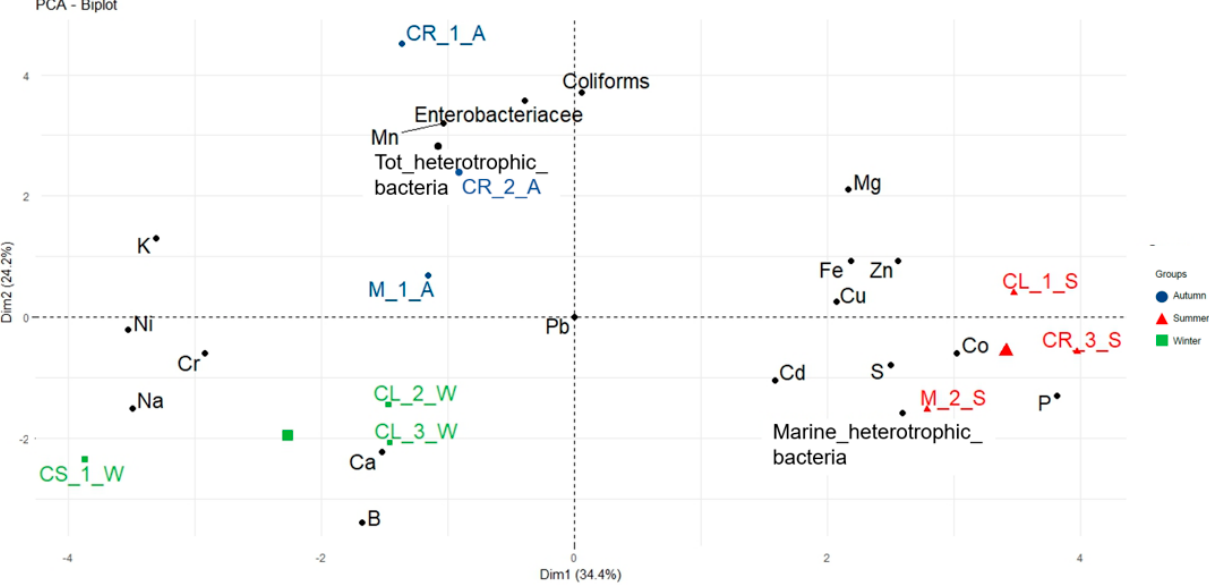
Figure 6. Principal component analysis of each fish species Chelon ramada (CR), Chelon labrosus (CL), Chelon saliens (CS), Mugil cephalus (MC) metal contents, and intestinal microbial loads along the seasons Autumn II (A), Winter III (W), Summer V